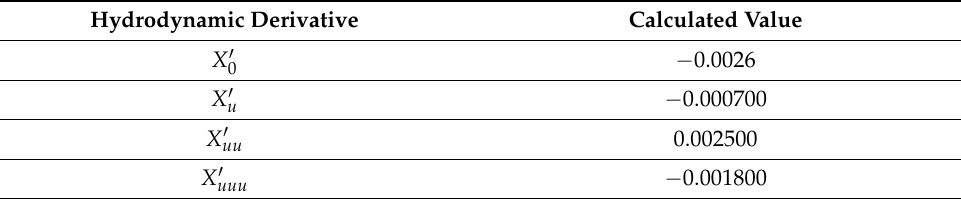
Table 2. Hydrodynamic